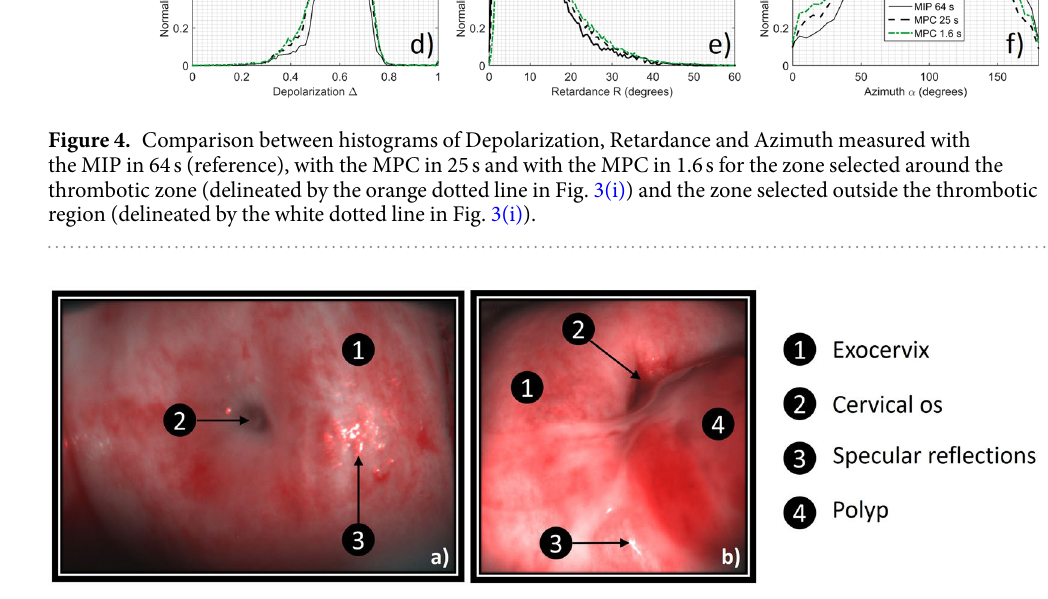
explored cervices. However, the uterine cervix shown in Fig. 5(b) is characterized by the presence of an endocer- vical polyp visible to the naked eye and easily identified by the practitioner as a benign growth of cervical tissue. White spots on the color pictures shown in Fig. 5 correspond to saturated camera pixels due to specular reflec- tion of light off of the surface of the sample. For the first patient, the selected ROI indicated as “Zone 1” in Fig. 6(a), corresponds to the exocervix. For the second patient, the first selected ROI, indicated as “Zone 2” in Fig. 6(e), corresponds to the exocervix while the second selected ROI, indicated as “Zone 3” in Fig. 6(e) corresponds to the polyp. The zones are delineated by yellow solid lines. The exocervix is the external visible part of the cervix entirely covered by a stratified squamous (also named malpighian) epithelium which is composed by flattened cells arranged in layers (for a total thickness of about 300 µ m). The polyp is covered by a simple columnar (also named glandular) epithelium which is composed by a mono-layer of elongated and column-shaped cells. The glandular epithelium generally covers the walls of the endocervical canal and should be not directly visible to the colposcopy. However, it often comes out the endocer- vical os and becomes visible due to benign modifications (ectropion) of the cervix (during pregnancy or in the ovulatory phase for younger women), or to the formation of endocervical polyps as described herein. Each epi- thelium is in direct contact with the basement membrane, a thin fibrous layer which separates it from the under- lying connective tissue mainly composed by collagenous and elastic fibers. Both types of epithelia can be found on the uterine cervix surface directly accessible to the colposcopic examination. Polarimetric characterization of squamous and glandular epithelia for healthy cervical tissue is the start point to detect precancerous lesions unambiguously. In order to obtain the polarimetric characterization in vivo of both described uterine cervices with the MPC, a single acquisition has been performed by setting the camera exposure time to 100 ms and the gain to unity as stated in the previous section, giving a total measurement time of 1.6 s. The MPC was used with ease by the sur- geon, as though it was a classic colposcope under real-world conditions.